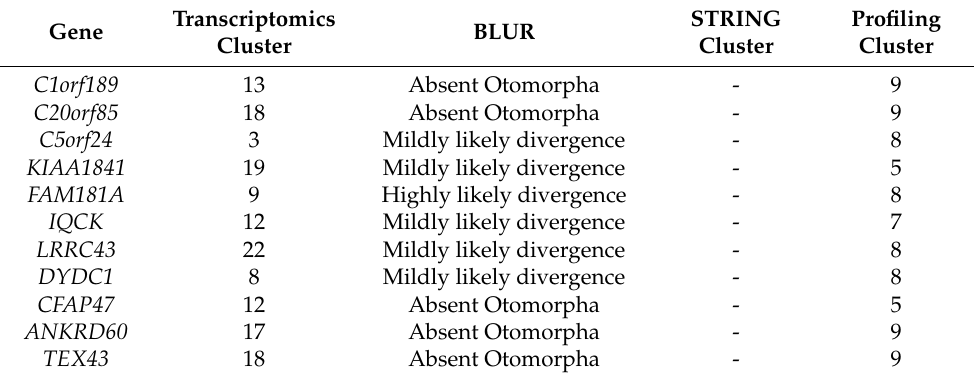
Table 3. Most promising target genes highlighted by all